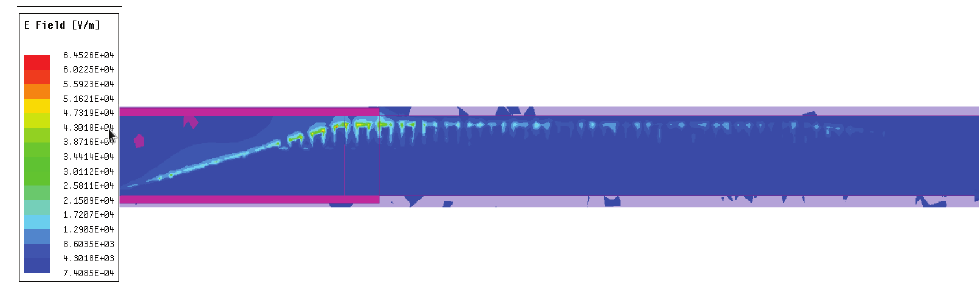
Figure 8. Field distribution: E-Field along the